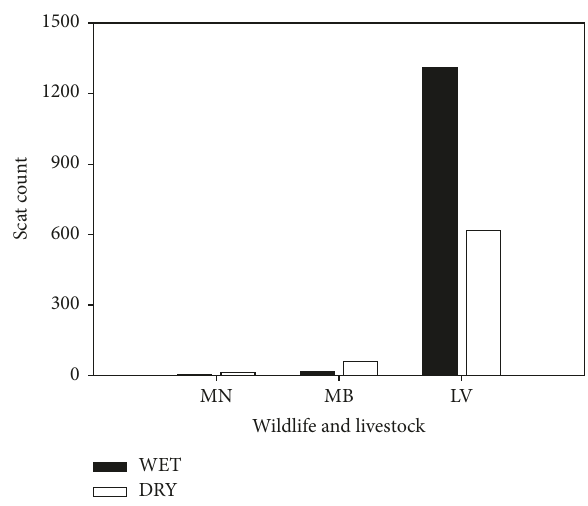
Figure 3: Mountain nyala (MN), Menelik’s bushbuck (MB), and livestock (LV) scat counts during dry and wet